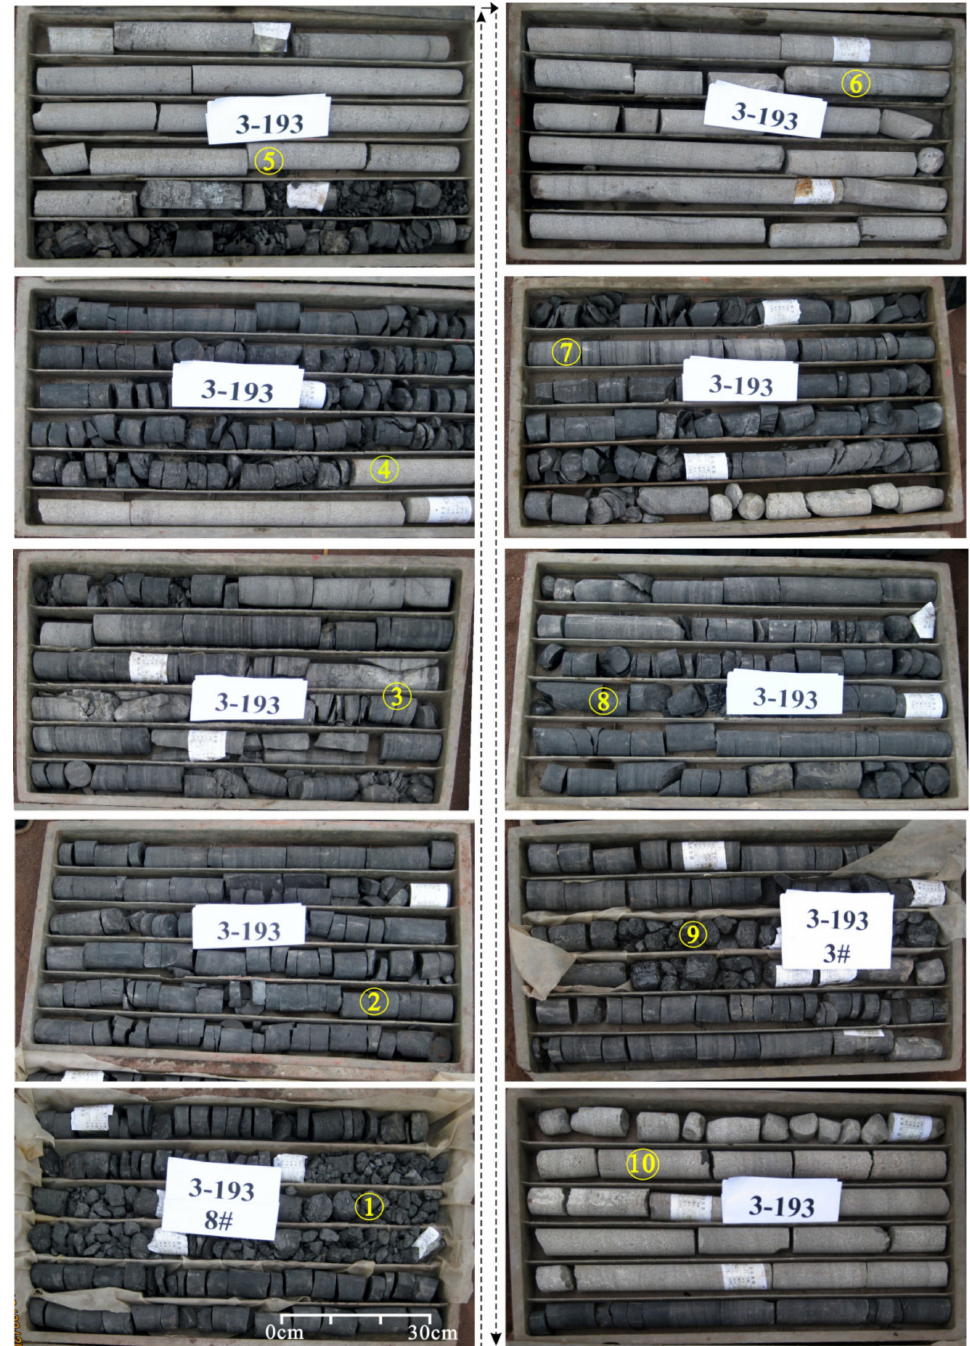
Figure 3. Core information of the coal-bearing series, showing a typical deltaic sedimentary sequence (well